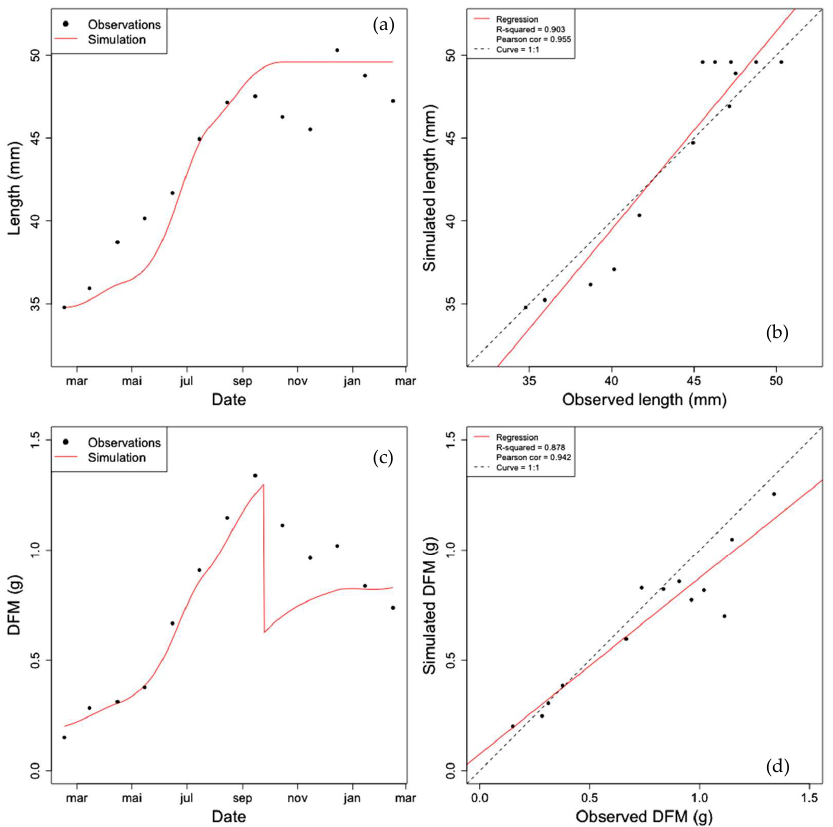
Figure A2. Calibration of the mussel DEB model used in this study to simulate shell length. ( a ) Mussel growth in length (mm), ( b ) Observed vs. simulated length; the dashed line corresponds to the 1:1 line, ( c ) Mussel growth in dry flesh mass (DFM, g); Note the strong decrease of DFM corresponding to spawning in September, ( d ) Observed vs. simulated DFM; the dashed line corresponds to the 1: 1 line.